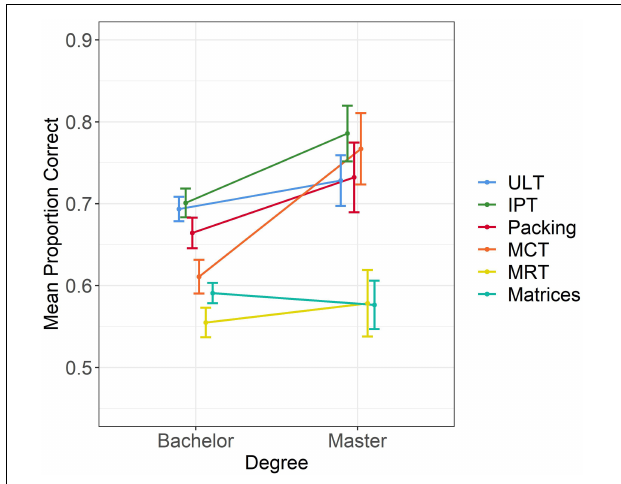
FIGURE 4 | Performance on the six tests split by degree. Error bars indicate 95% confidence